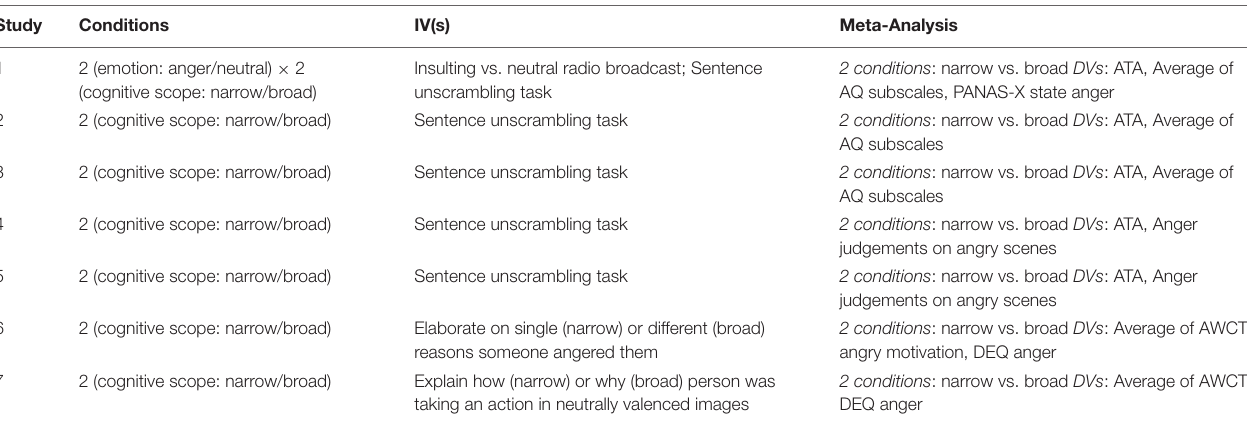
TABLE 8 | Study designs and variables included in meta-analysis.